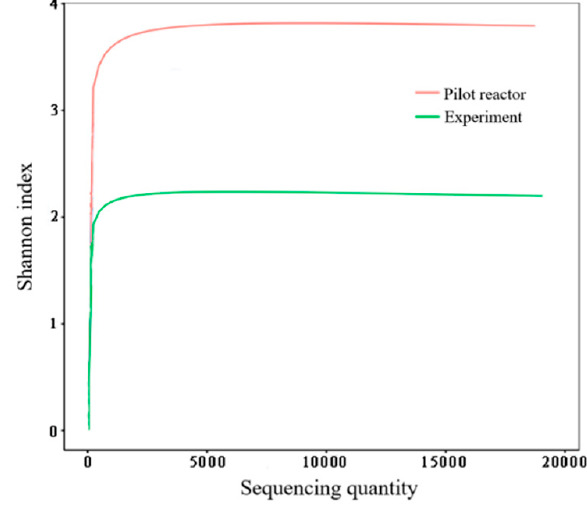
Figure 13. Sparse distribution of the Shannon index.